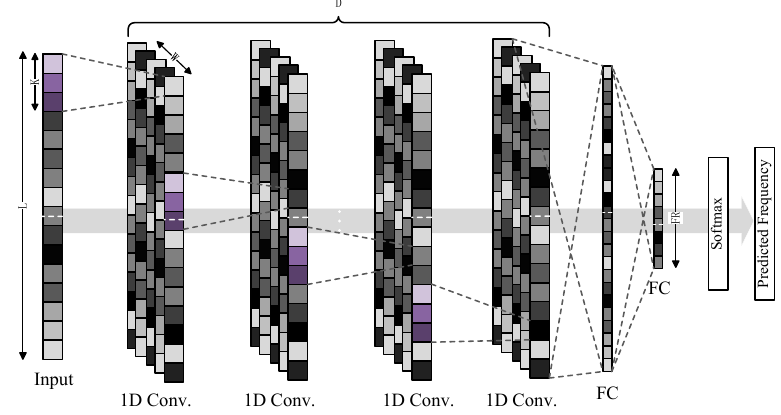
Figure 1. Convolutional neural network architecture of proposed method.